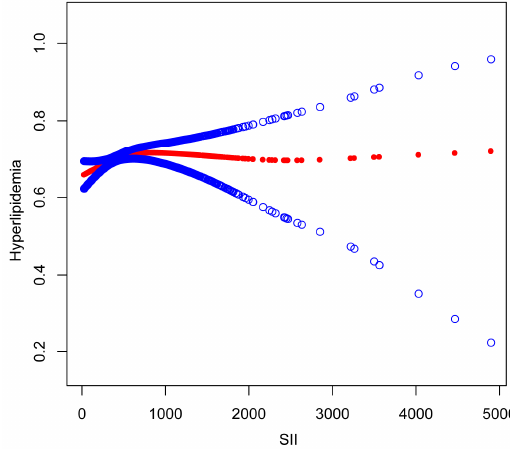
Figure 3. The association between SII and hyperlipidemia. The solid red line represents the smooth curve fit between variables. Blue bands represent the 95% confidence interval from the fit.